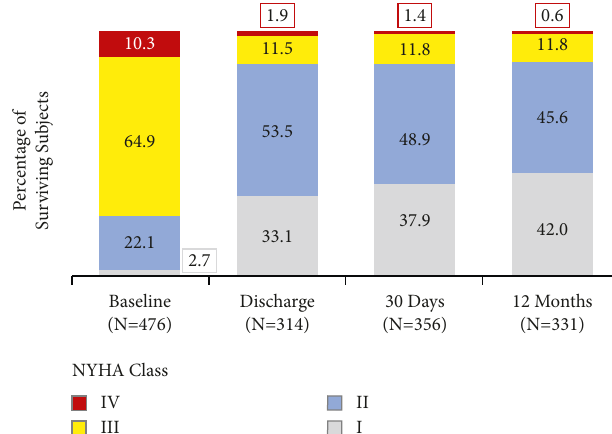
Figure 5: Improvement in functional status. Improvement in functional status, based on New York heart association (NYHA) functional class, was evident at discharge and sustained through 12 months of follow-up. Analysis includes surviving subjects treated with ACURATE neo who had functional status recorded at a given time